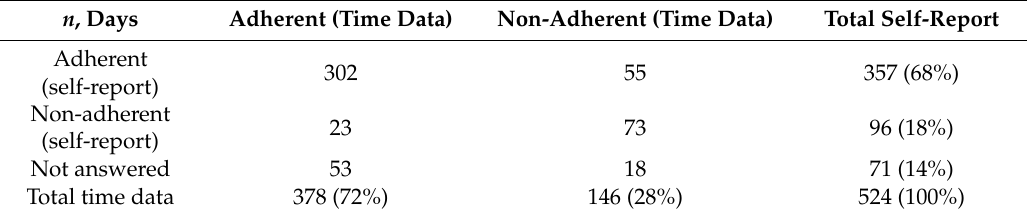
Table 3. Comparison of self-reported (written, handbook) versus time-stamped photo adherence to